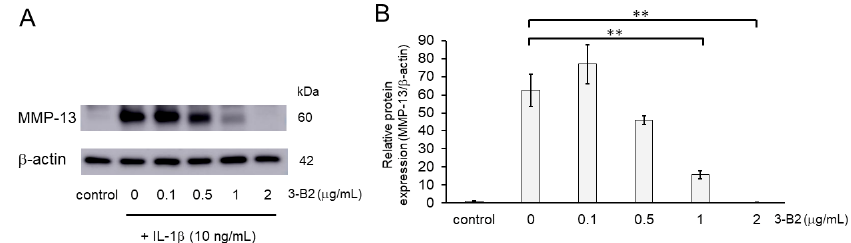
Figure 7. Inhibitory effects of 3-B2 on IL-1 β -induced MMP-13 protein expression. ( A ). Western blot analysis of the relative protein level of MMP-13. Pre-treatment with 3-B2 for 6h significantly de- creased the protein expression of MMP-13, which was induced by IL-1 β (10 ng/mL) in a dose-de- pendent manner. ( B ). Quantitative estimation of the protein levels of MMP-13 after 3-B2 pre-treat- ment and IL-1 β induction. Values represent mean ± SE ( n = 4 per group). ** p < 0.01.